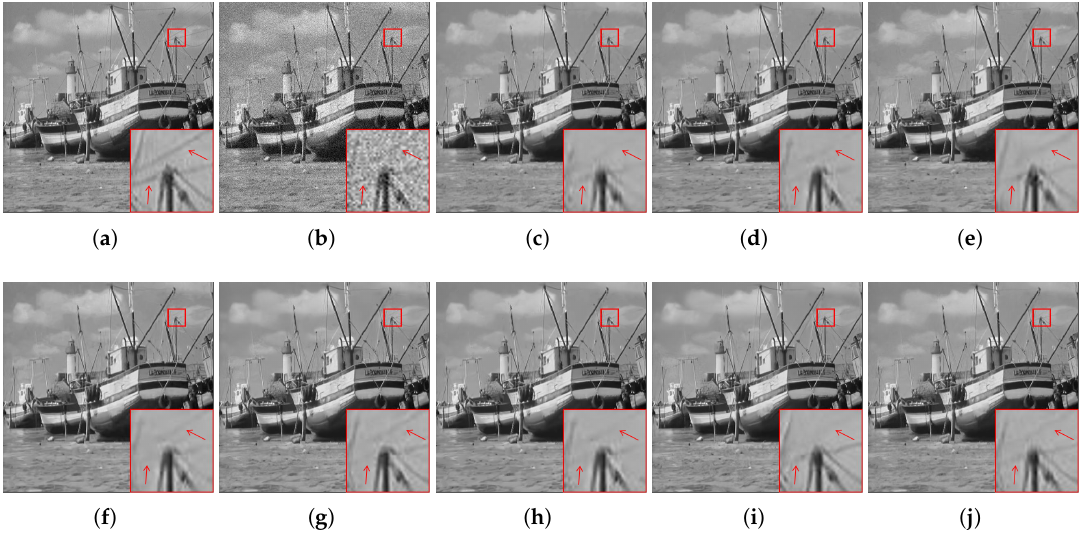
Figure 6. Comparison of denoising results of the competing methods for image Boat with noise level σ = 20. ( a ) Original image. ( b ) Noisy image. ( c ) NCSR, PSNR = 31.02 dB. ( d ) WNNM, PSNR = 31.31 dB. ( e ) PGPD, PSNR = 31.06 dB. ( f ) BM3D, PSNR = 31.21 dB. ( g ) DnCNN, PSNR = 31.44 dB. ( h ) TWSC, PSNR = 31.29 dB. ( i ) FFDNet, PSNR = 31.43 dB. ( j ) Proposed, PSNR = 31.76 dB.